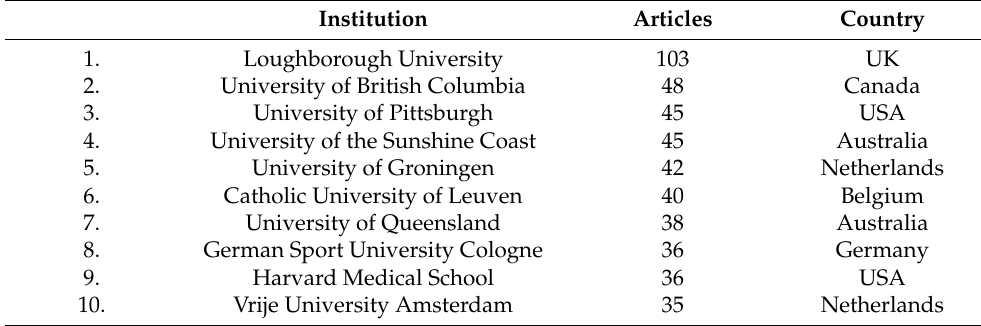
Table 2. The top 10 institutions contributed to publications on adapted sport research.